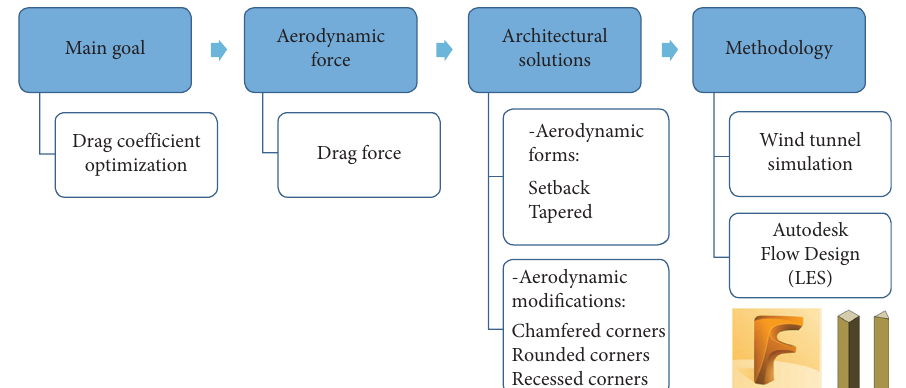
Figure 4: Research framework flowchart.